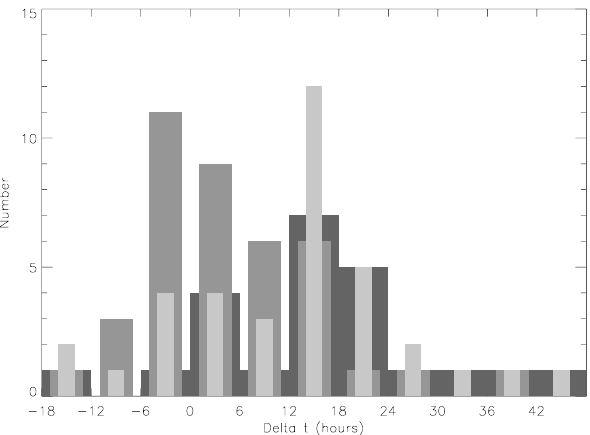
Fig. 5. Scatter plot of 1T with respect to the apparent velocity measured in LASCO V LASCO .